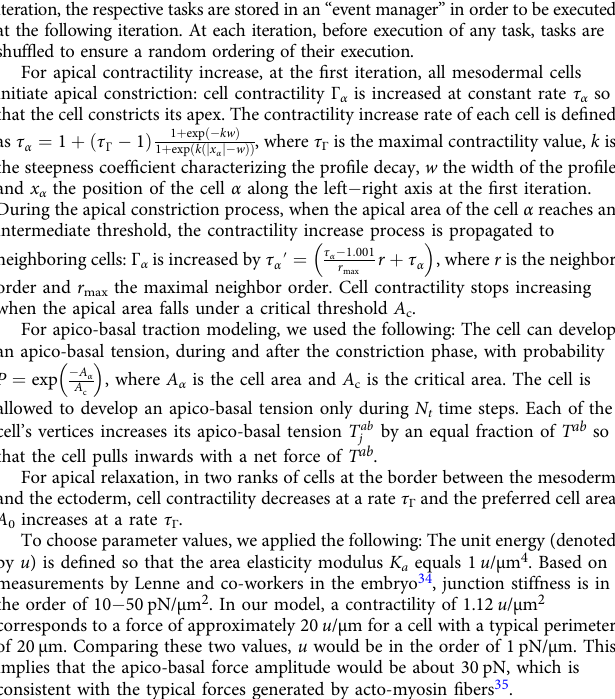
algorithm from the scipy library 33 . Results are displayed using the Matplotlib (https://doi.org/10.5281/zenodo.1202077) and Ipyvolume libraries (https://doi. org/10.5281/zenodo.1286976). For cell dynamics in the tissue, we used the following: cells can undergo different processes: apical contractility increase, apico-basal traction, apical relaxation. At